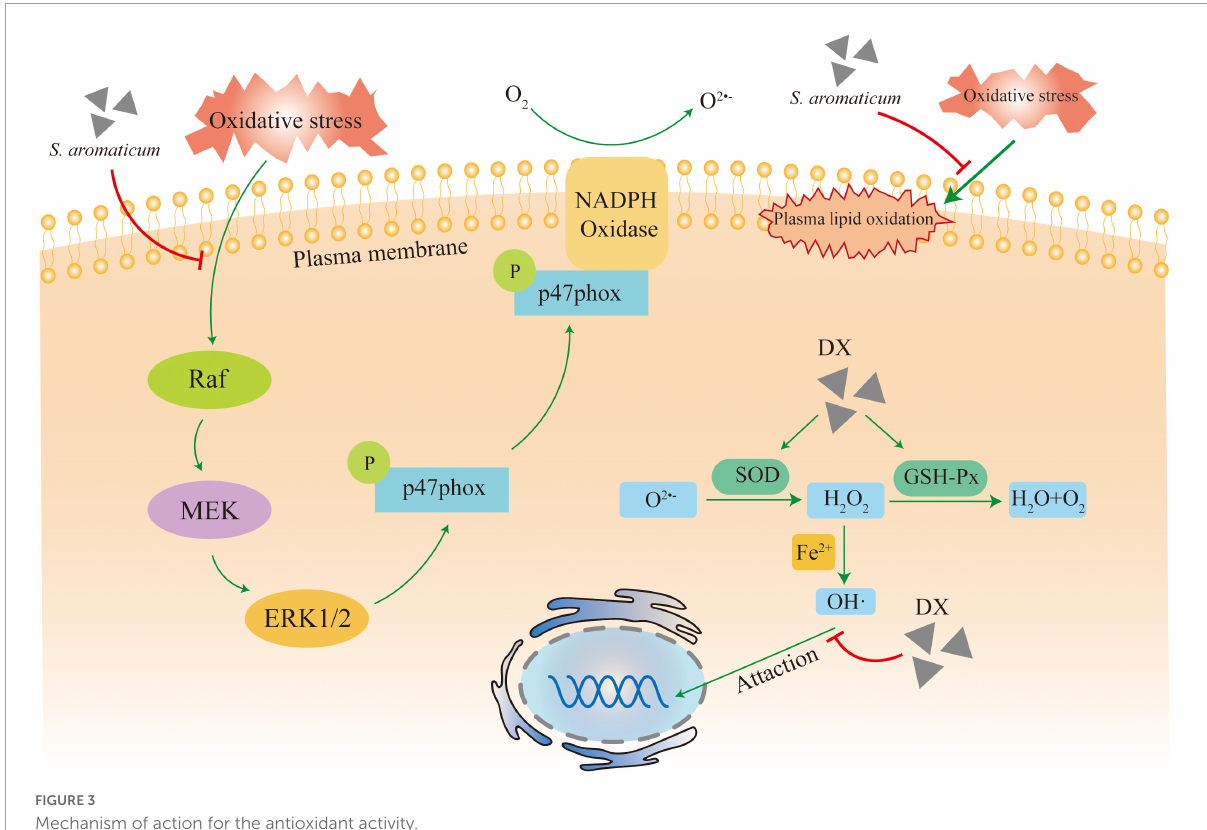
FIGURE3 Mechanism of action for the antioxidant